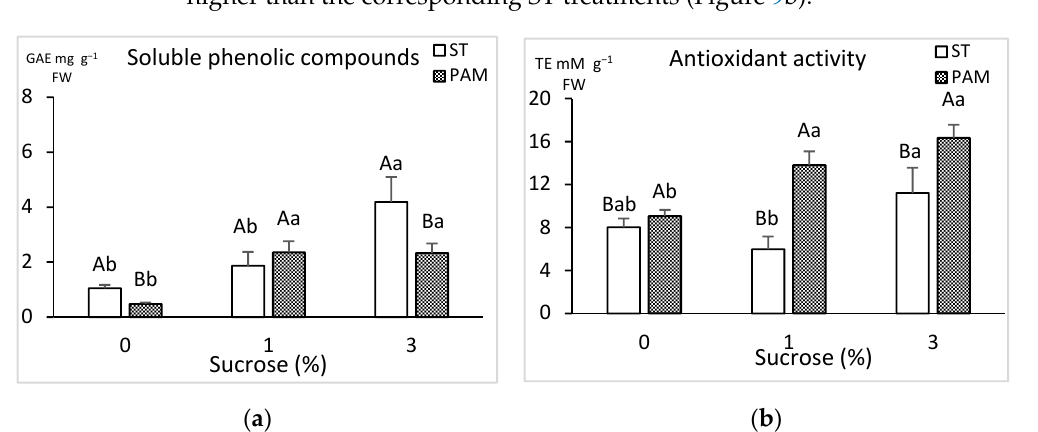
Figure 11. Shoots of CFN cultured in jars and RITA© with 3% sucrose and rooted in rockwool cubes. ( a ) Shoots proliferated in jars 6 weeks after auxin treatment and ( b , c ) plantlets from shoots prolifer- ated in RITA© after being transferred to the phytotron ( b ) and 3 months later in the greenhouse ( c ). Rooting and acclimation responses averaged 90%, and we did not observe differences in the percentages of shoots rooted in SSM or in rockwool cubes. Shoots rooted in cubes were easier to handle without compromising the integrity of the roots, whereas some roots were broken when the shoots were extracted from the jars, and cubes were used thereaf- ter. 3.5. Effect of Sucrose Supplementation on Rooting and Acclimation Figures 12 and 13 show the rooting response of CBP shoots cultured in ST or PAM with 0, 1 or 3% sucrose and rooted in rockwool cubes soaked with medium containing 0, 1 or 3% sucrose. Figure 12 shows quantitative data and Figure 13 the appearance of the shoots after rooting and during acclimation. None of the three investigated factors (growth conditions, sucrose during multiplication and rooting) had a significant effect on rooting ( p values were 0.238, 0.536 and 0.128 for growth conditions, sucrose during mul- tiplication and sucrose during rooting, respectively), and shoots from all the treatments rooted and acclimated successfully (Figures 12 and 13). However, when shoots were mul- tiplied without sucrose the proportion of rootable shoots was lower than in the rest of treatments, meaning more bioreactors had to be used to obtain enough shoots for the root- ing experiments.